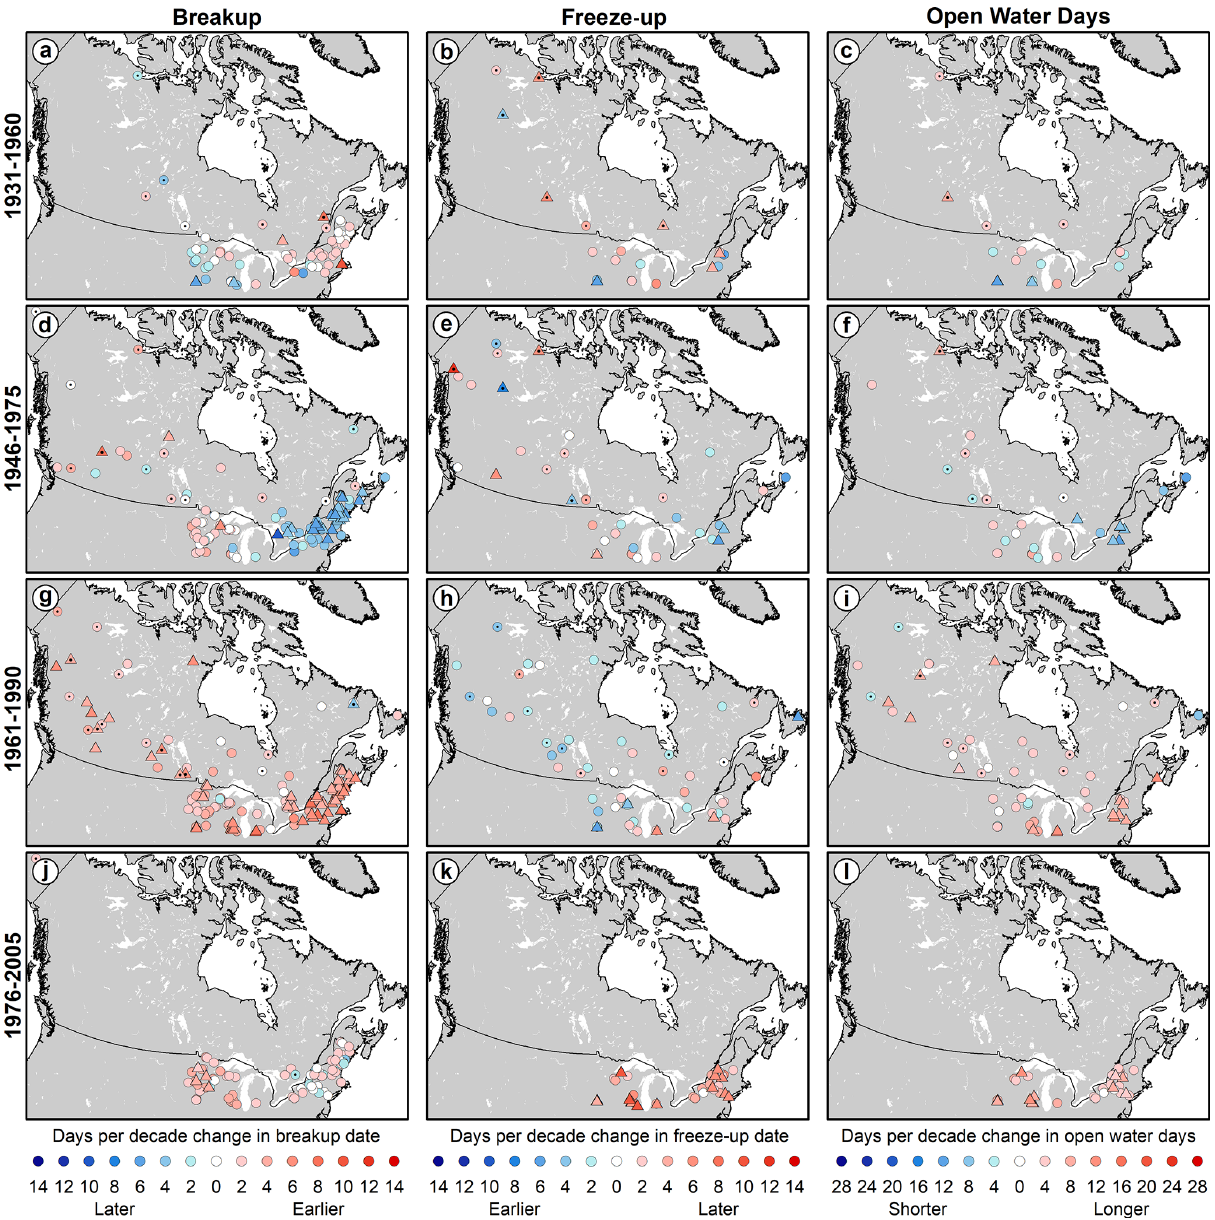
Figure 4. Decadal trends for breakup (a, d, g, j) , freeze-up (b, e, h, k) , and the number of annual open-water days (c, f, i, l) in North America for the four individual time periods. The trend directions and magnitudes were derived from the Mann–Kendall and Sen’s slope tests. The triangles and circles indicate whether the trend was or was not statistically significant. Sites with a dot in the centre of the circle are river sites. Thus, a red triangle symbol with a dot in the middle indicates a river site that has a statistically significant warming trend over that time period. The blue and red tones on the scales are related to cooling and warming trends, respectively. Note that in some places the symbols